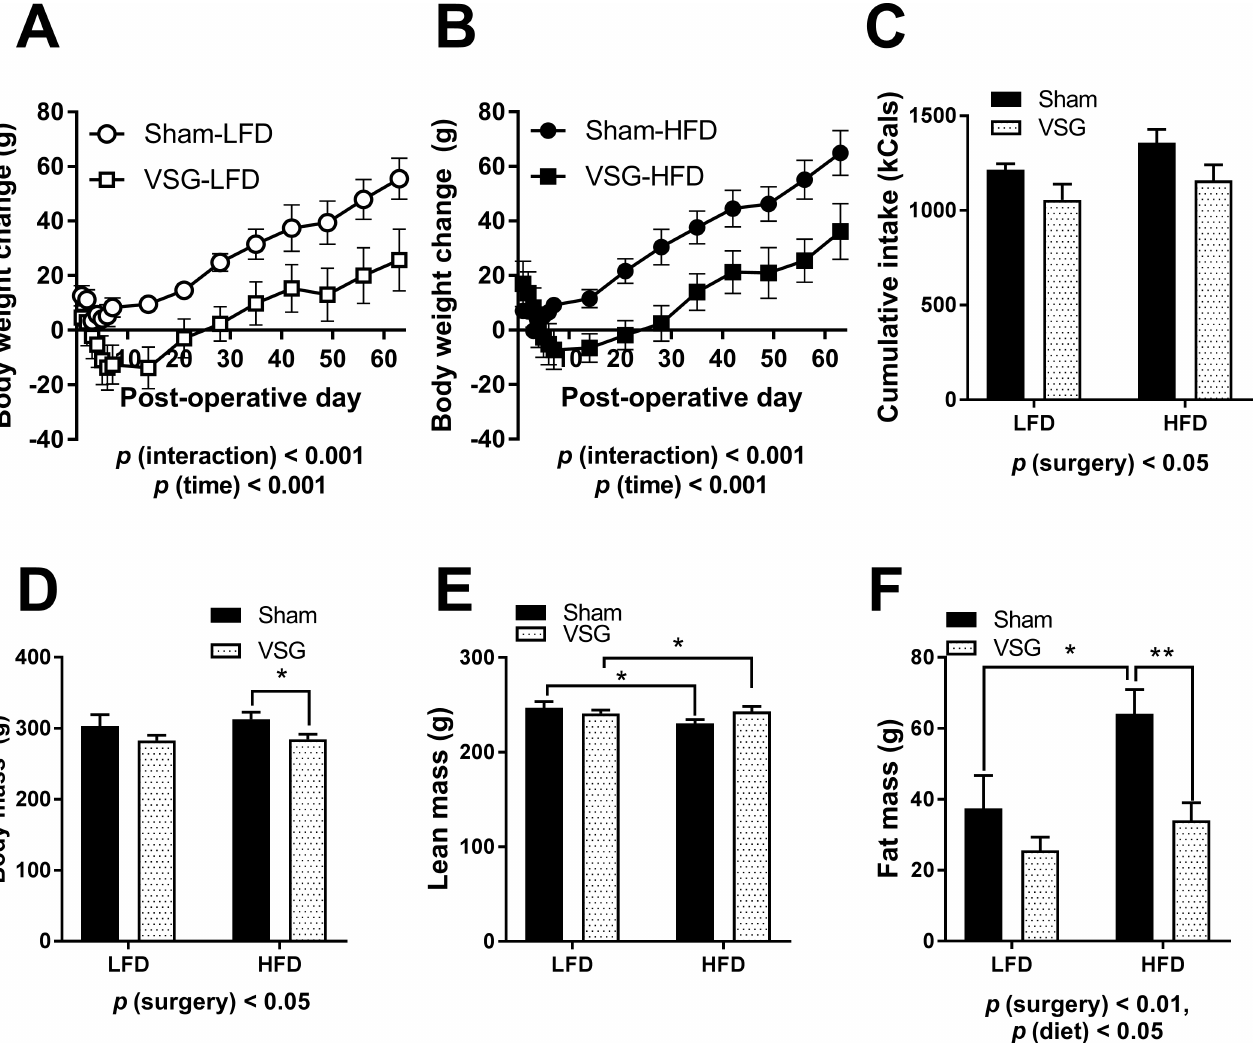
Fig 1. Metabolic parameters of female rats on LFD and HFD. Body weight following surgery for animals on (A) LFD and (B) HFD (C) Average daily food intake in kCal during the first 3 weeks after surgery. Body composition was measured at day 35 post surgery (D) Body mass (E) Lean mass (F) Fat mass. Data are presented as mean ±SEM. N = 5-7/group. (cid:3) p < 0.05, (cid:3)(cid:3) p < 0.01.